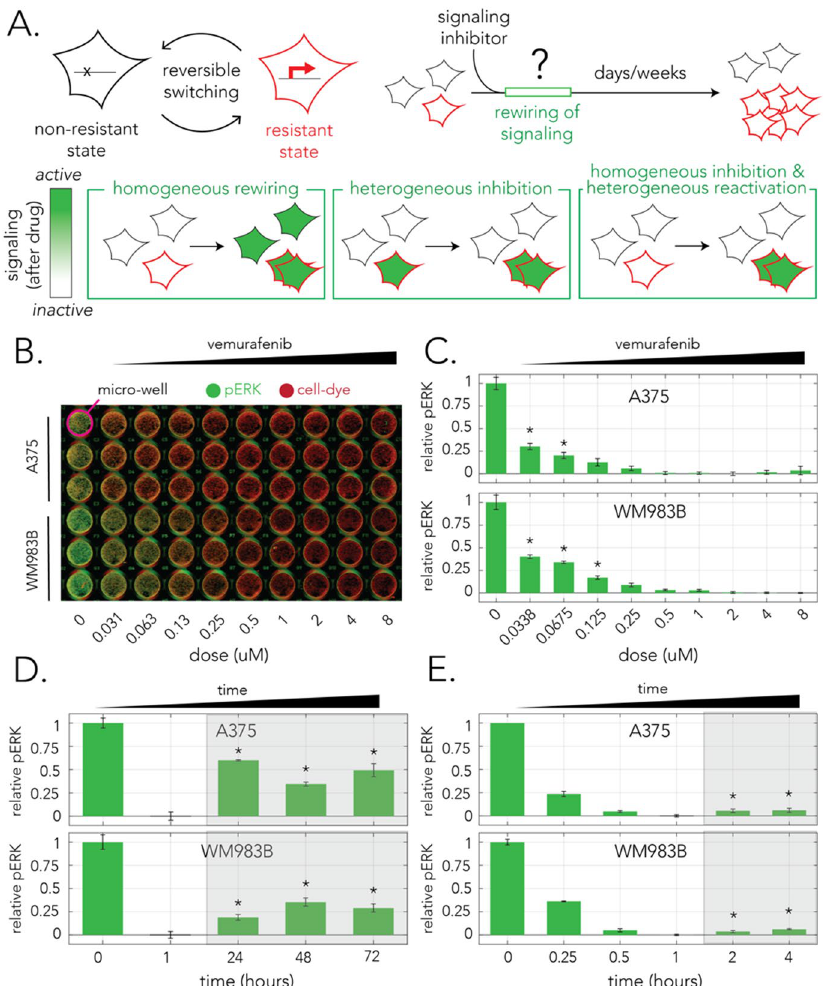
Figure 1. Reactivation of ERK signaling after vemurafenib treatment in bulk populations. ( A ) The epigenetic- based model for drug resistance and alternative models for signaling rewiring. High expression of a set of genes is thought to underlie a reversible drug-resistant state (upper-left panel). A small subpopulation of drug-resistant cells proliferates more than kin-cells after drug administration, however, the dynamics of signaling rewiring immediately after drug treatment in individual cells remains unknown (upper-right panel). The lower panels show three alternative models for signaling rewiring consistent with measurements from bulk populations. ( B ) A representative image of the immunofluorescence signal in the in-cell-western (ICW) method used for monitoring signaling activity 1 h after treatment. Cells growing in a micro-well plate were fixed and stained with an antibody specific for phosphorylated ERK (green). The wells were co-stained with a cell-dye (red) to monitor population size. The ratio between the two signals (green/red) marks the ERK activity normalized to cell number. ( C ) Vemurafenib impact on ERK signaling at different concentrations. The bars mark the relative pERK levels 1 h after treatment. ( D ) Vemurafenib impact on ERK signaling after multiple days of treatment. In both cell-lines, signaling recovers and rebounds to intermediate levels already within the first 24 h (reactivation period is marked by shaded area). ( E ) Vemurafenib impact on ERK signaling after multiple hours of treatment. In both cell-lines, signaling inhibition is maximized 1 h after treatment and then marginally recovers within 2 h (shaded area). In all graphs ( C–E ), green bars mark the relative pERK levels after treatment averaged over 3 biological replicates and thin black bars mark standard deviation. The relative ERK activity is calculated by comparing its normalized level to the minimum and maximum levels observed. Stars mark pERK levels that are statistically higher than the maximum inhibition observed (one-tailed t-test with a Bonferroni corrected p -value for multiple statistical